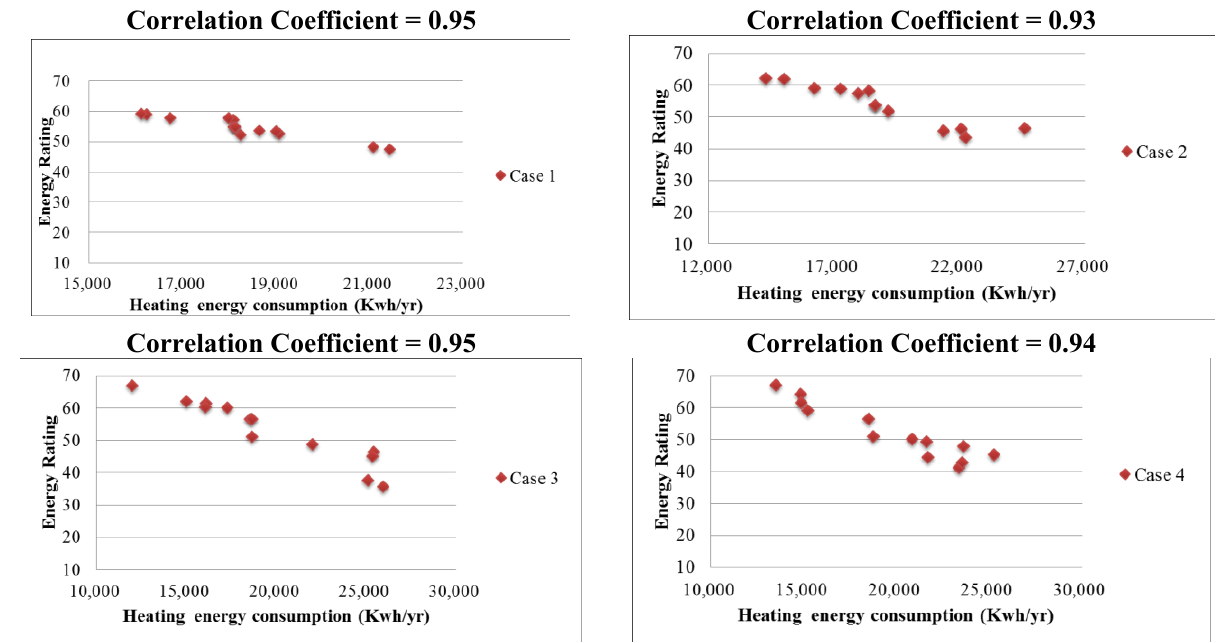
Table 10. Correlation coefficient with estimated energy